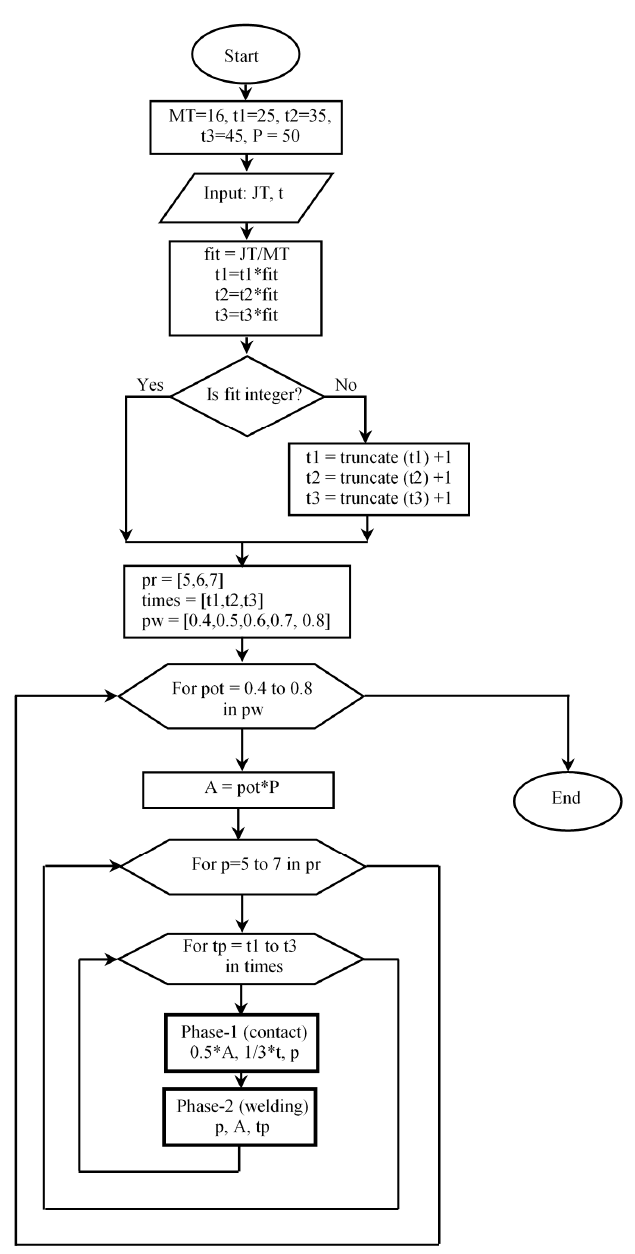
Figure 4. Flow diagram of the welding process with each different joint thickness.